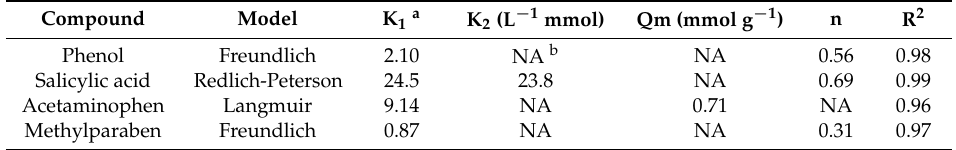
Figure 3. Adsorption isotherm of phenol, acetaminophen, salicylic acid, and methylparaben on activated carbon CAO at 293 K. Table 8. Parameters of Langmuir, Freundlich, Redlich-Peterson, and Sips models for phenol,